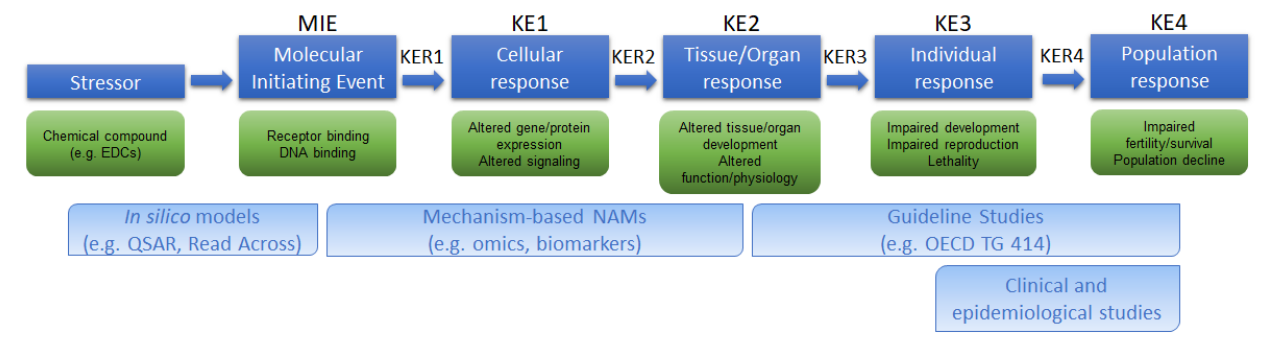
Figure 1. Schematic representation of the AOP conceptual framework. The Molecular Initiating Event (MIE) is triggered by a stressor and determines a cascade of key events (KE) causally linked by key events relationships (KERs). For each step, different investigation approaches may be applied according to the increasing complexity of the biological level observed.